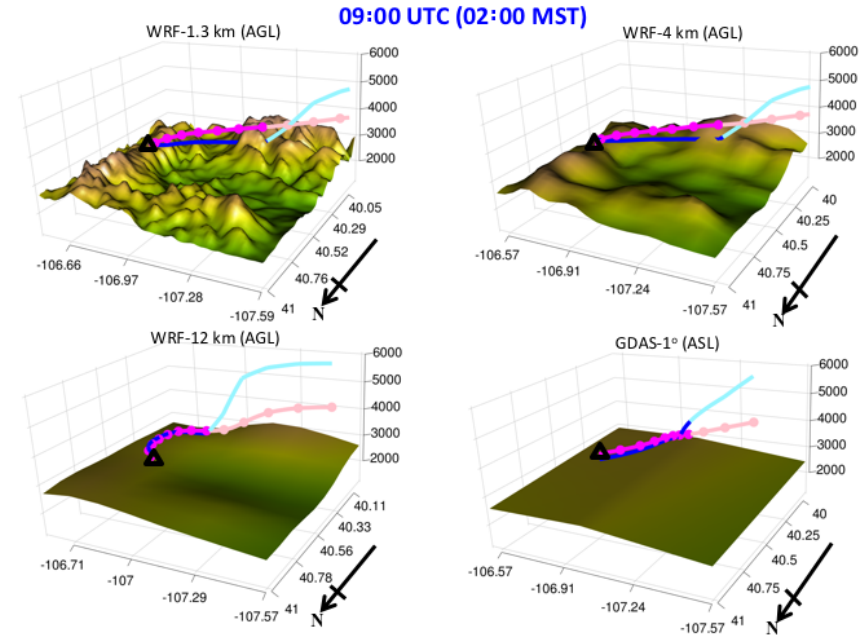
Figure 9. Similar to Fig. 7, but for the Storm Peak Laboratory (SPL)